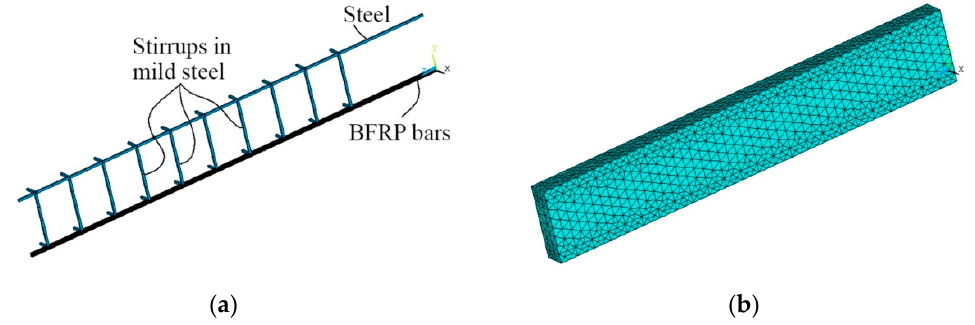
Figure 4. Finite element model of the BFRP-reinforced beam, generated finite element mesh: ( a ) longitudinal reinforcement in the compression zone (blue), stirrups (blue), and BFRP reinforcement (black); ( b ) concrete.